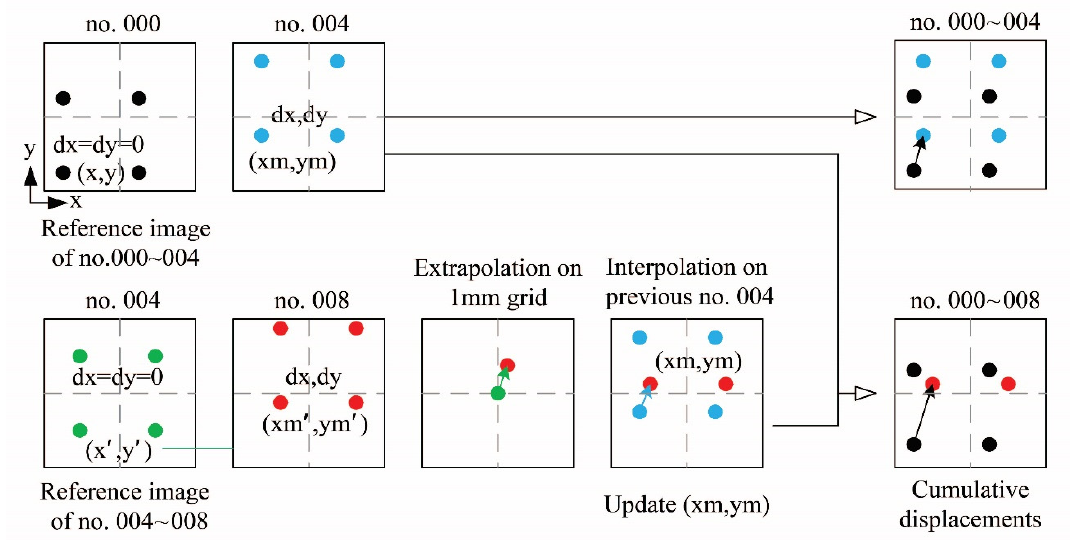
Figure 14. Scheme of interpolation and extrapolation for integration of cumulative displacement fields.